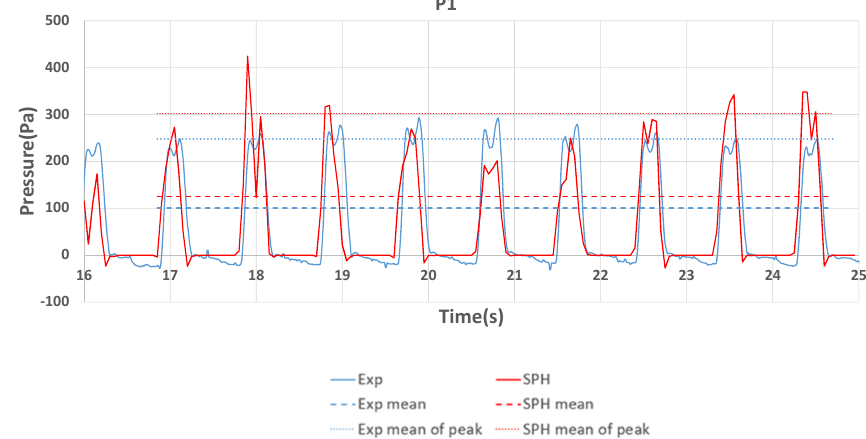
Figure 9. Impact pressure under sway excitation with a particle spacing of 0.8 mm at a 25% filling ratio.